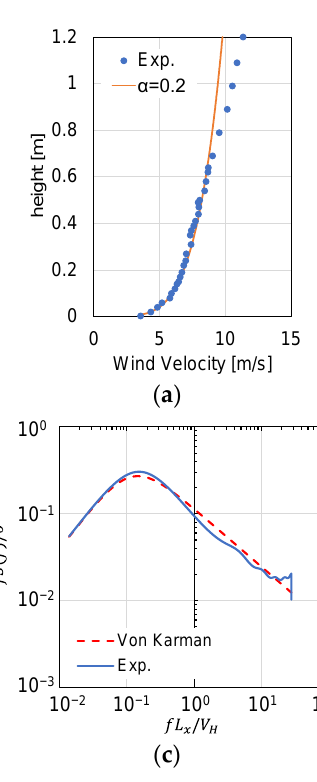
Figure 4. Characteristics of approach flow: ( a ) mean wind velocity; ( b ) turbulent intensity; ( c ) power spectrum density.